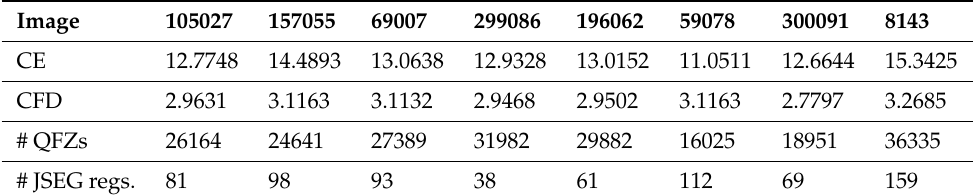
Table 2. Color entropy and color fractal dimension, number of quasi-flat zones and number of regions segmented using JSEG for the eight images depicted in Figure 2, from the BSDS500 data set.